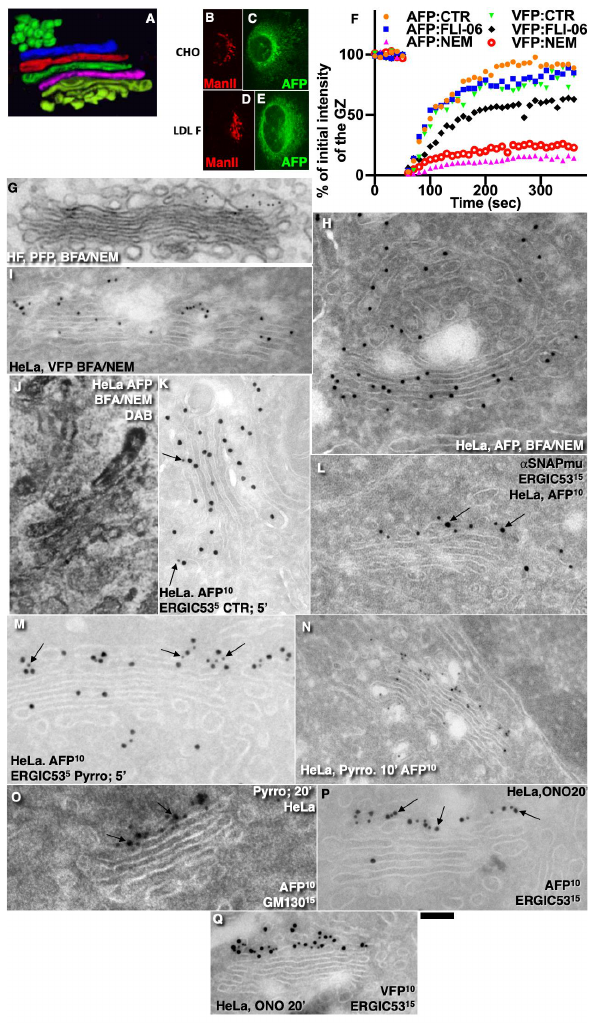
Figure 8. Functional coatomer I, membrane fusion, and stability of intercisternal tubules are im- portant for IGT. ( A ) Three-dimensional model of the Golgi ministack transporting VFP. In the trans- porting Golgi stack, all Golgi cisternae (different colors) are connected. ( B – E ) Both control CHO cells ( B , C ) and ldl F cells ( D , E ) were heated at 40 °C for 2 min to block the ability of COPI in ldl F cells to form vesicles [11,22]. In the heated CHO cells, concentration of AFP within the GC increased ( C ), whereas in ldl F cells, this enrichment was lower ( E ). Green color indicates labelling for AFP. Red color indicates ManII. ( F ) Role of COPII, COPI, and SNAREs during IGT. Fluorescence intensity of the bleached Golgi area in cells transfected with AFP or VFP synchronized according to the iFRAP pro-